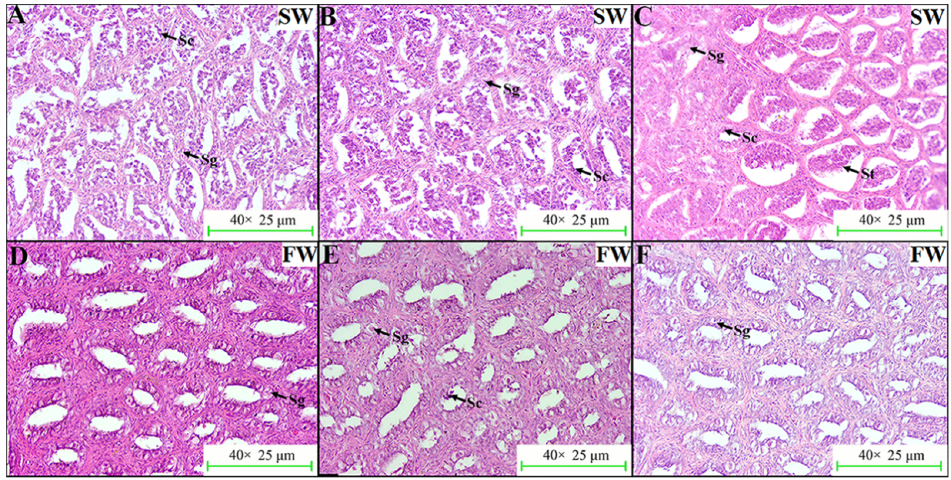
Figure 7. Effects of salinity change on L. maculatus testes with H&E staining. ( A – C ) Testes slides from three specimens of the seawater (SW) group. ( D – F ) Testes slides from three specimens of the freshwater (FW) group. The pictures are shown as 40 × views. Sg: spermatogonia; Sc: spermatocyte; St: spermatid.